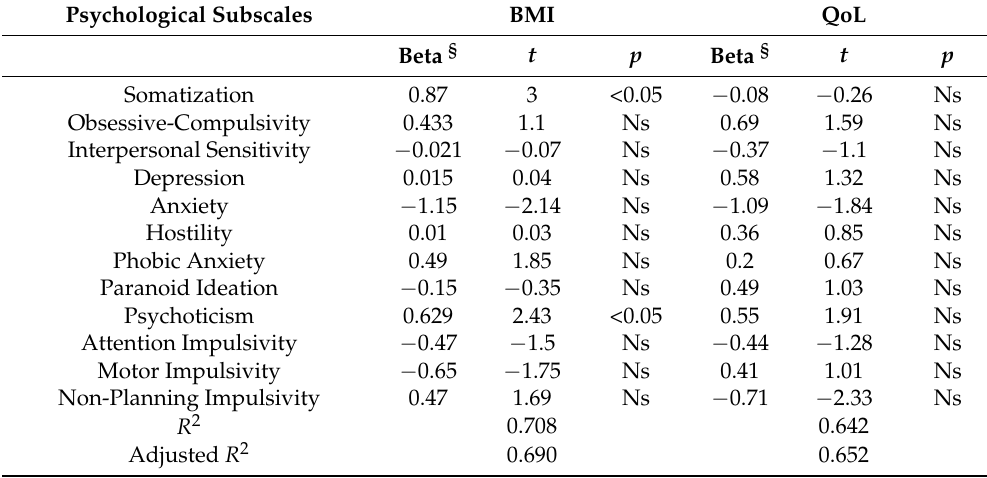
Table 2. R 2 , beta, t , and p values of regression analysis, conducted to evaluate the possible impact of men’s psychopathological symptoms and impulsivity (predictor variables) on their BMI and quality of life (dependent